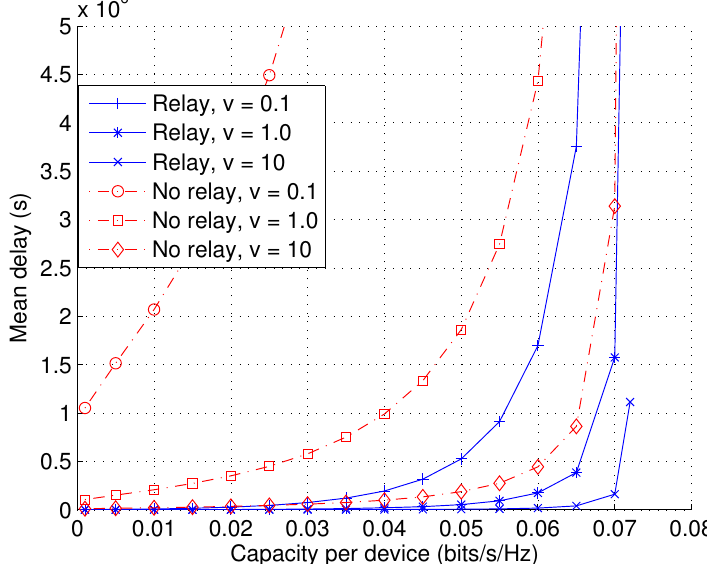
Figure 11. Mean delay ¯ D as a function of capacity per device C with varying user mobile speed v ( L = 1, P I = ∞ , P II = ∞ , λ b = 10 − 5 , arbitrary λ u